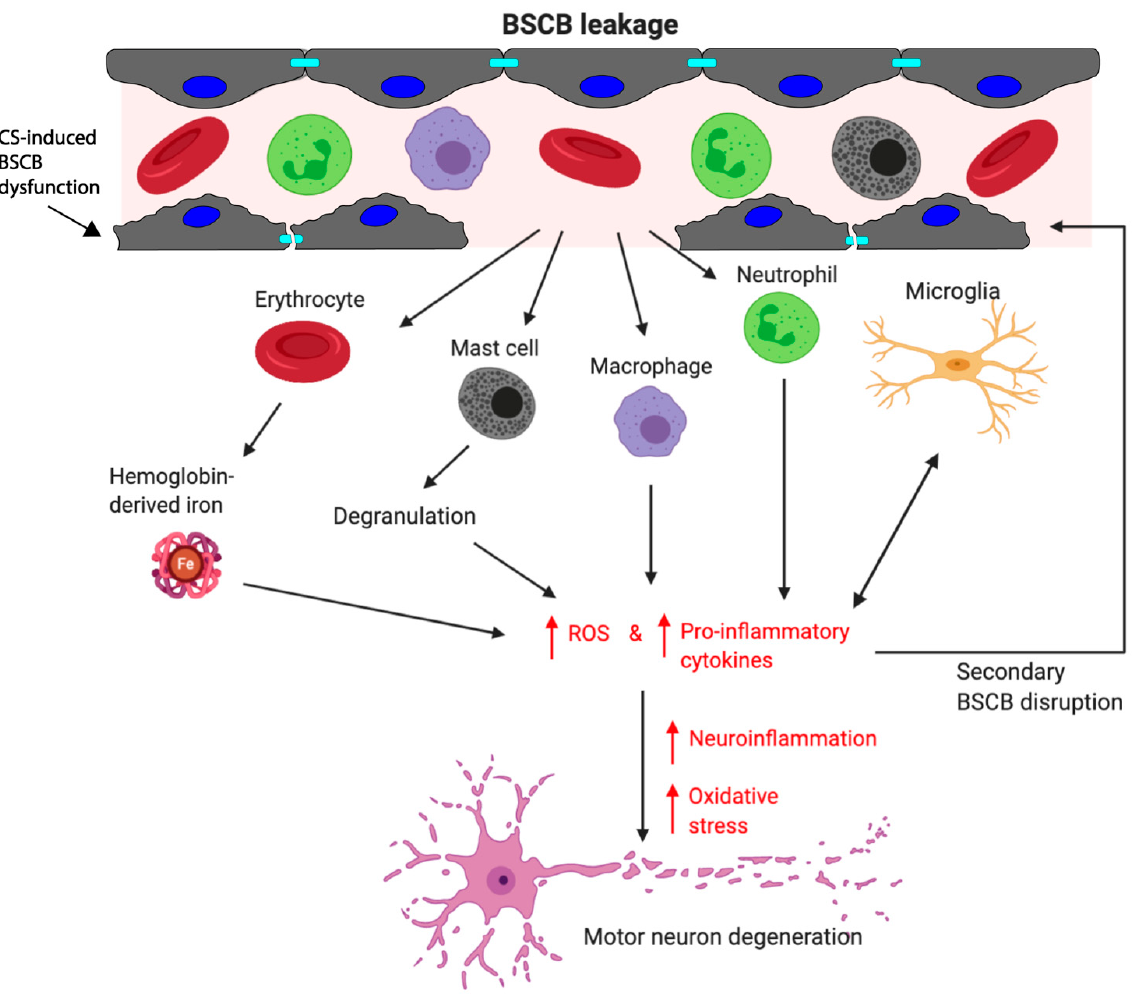
Figure 2. Blood–spinal cord barrier (BSCB) leak establishes a neurotoxic environment for motor neurons. Primary damage to BSCB components by cigarette smoke (CS) exposure increases the permeability to pro-inflammatory immune cells such as mast cells, macrophages and neutrophils along with red blood cells that give rise to iron-containing haemoglobin. This leads to the generation of ROS and neuroinflammatory cytokines that increase motor neuron oxidative stress and exacerbate other neurodegenerative mechanisms in ALS. These include protein aggregation, alterations in axonal transport, endoplasmic reticulum stress responses and mitochondrial dysfunction. These pro-inflammatory cytokines and ROS also activate surrounding microglia which, in turn, release cytokines and ROS, further contributing to neurodegeneration. The inflammatory cytokines produced by microglia and pro-inflammatory cells further increase neuroinflammatory processes of motor neuron degeneration. Additionally, secondary BSCB dysfunction may occur concurrently with primary BSCB dysfunction. Here, oxidative and neuroinflammatory processes associated with the neurotoxic environment may extend back to the BSCB, facilitating secondary damage. This augments permeability and increases immune-cell migration, aiding the development and maintenance of a neurotoxic environment.